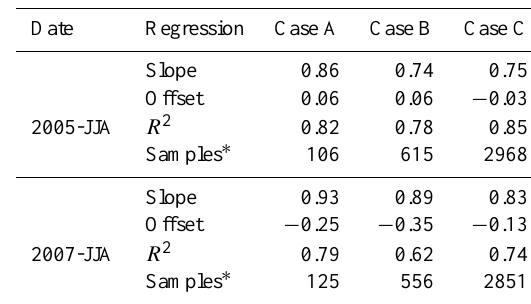
Table 3. Reduced Major Axis regression analysis between OMI (x- axis) and GEOS-Chem (y-axis) summer (June to August) average NO 2 columns in 2005 and